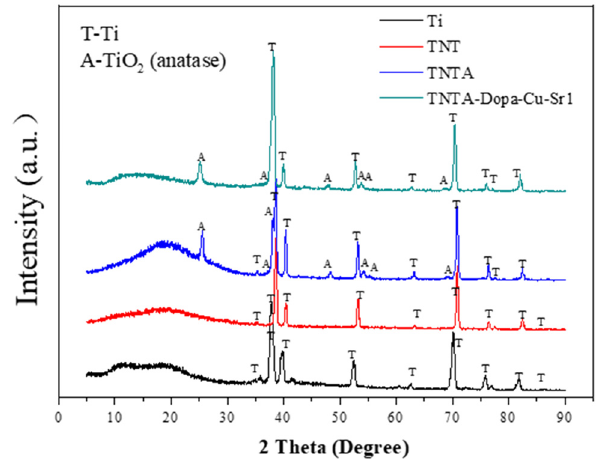
Figure 3: XRD of pure Ti, TNT, TNTA, and TNTA – Dopa – Cu –